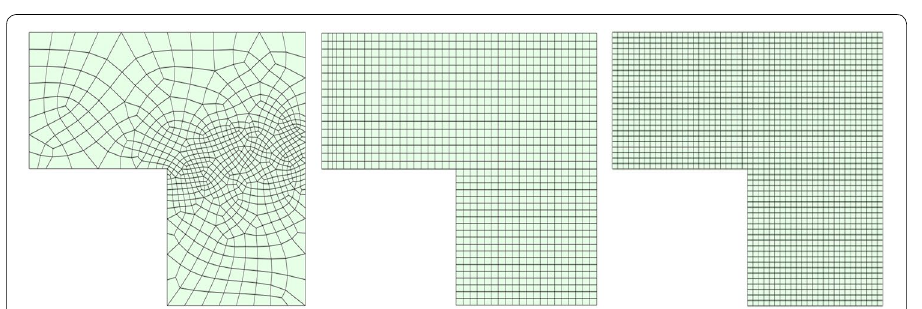
Fig. 12 Finite element meshes used, namely Mesh1 (left), Mesh2 (centre) and Mesh3 (right)